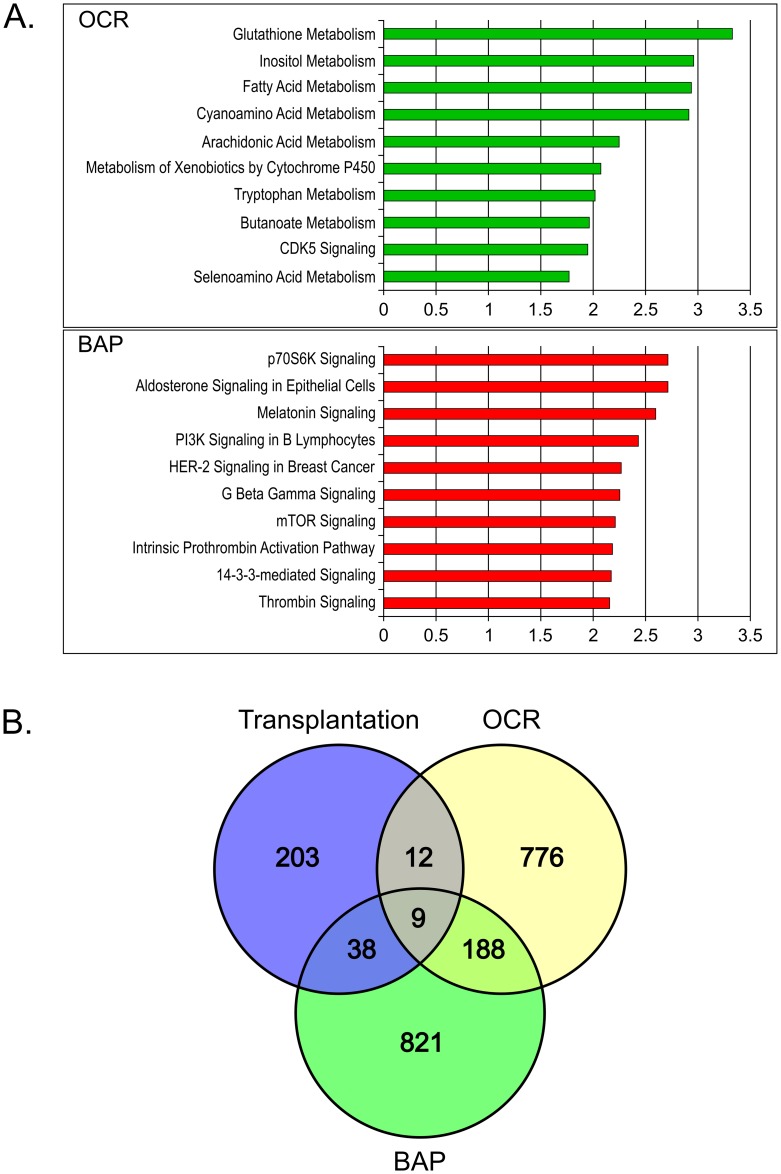
Canonical pathways of the OCR and BAP classifier sets.The results of Ingenuity Pathway Analysis of the probeset classifier lists associated with OCR and BAP. The top ten pathways associated with OCR (green) and BAP (red) are listed in order of the level of statistical significance (-log(p-value)). Pathways associated with OCR are mostly metabolic, whereas those associated with BAP are various signaling pathways. B. Venn diagram of the probeset classifier lists from diabetic mouse data (Transplant), OCR results, and BAP shows that there is overlap of only 9 probesets. This indicates that the three parameters are measuring distinct characteristics of islet function, which is supported by the diversity of functional pathways associated with each parameter. The diagram was created using the VENNY website tool [20].